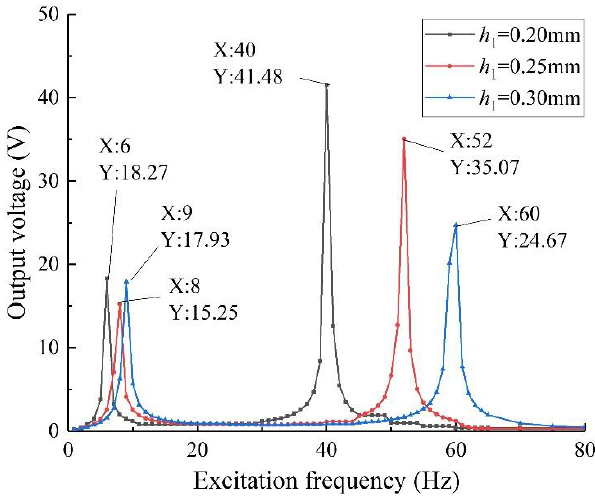
Figure 9. Output voltage of different piezoelectric beam base thickness.